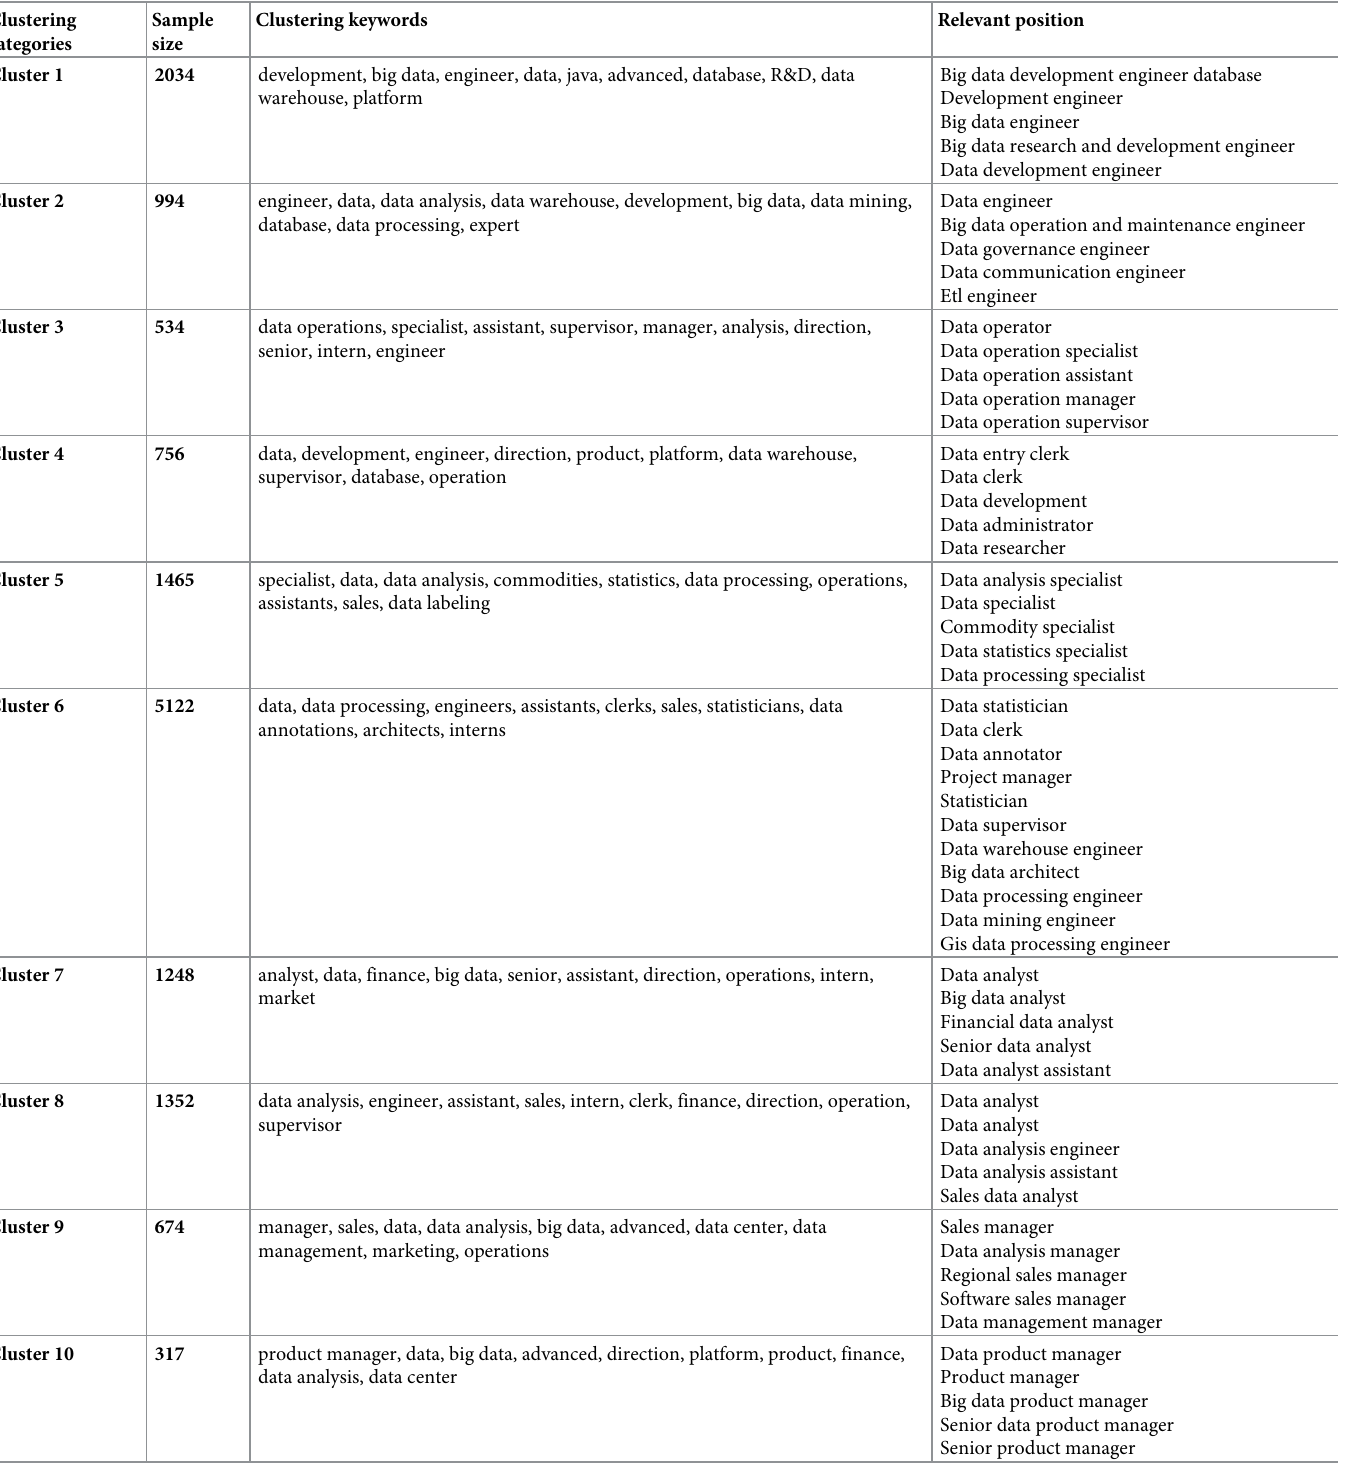
Table 3. K-means clustering results and related positions. Clustering